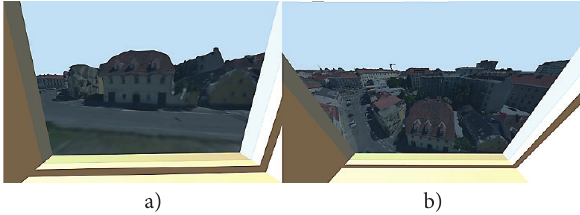
Figure 7. Practical r esearch of proposed window visibility analysis: a – the view from the second fl oor; b – the view from the ninth fl